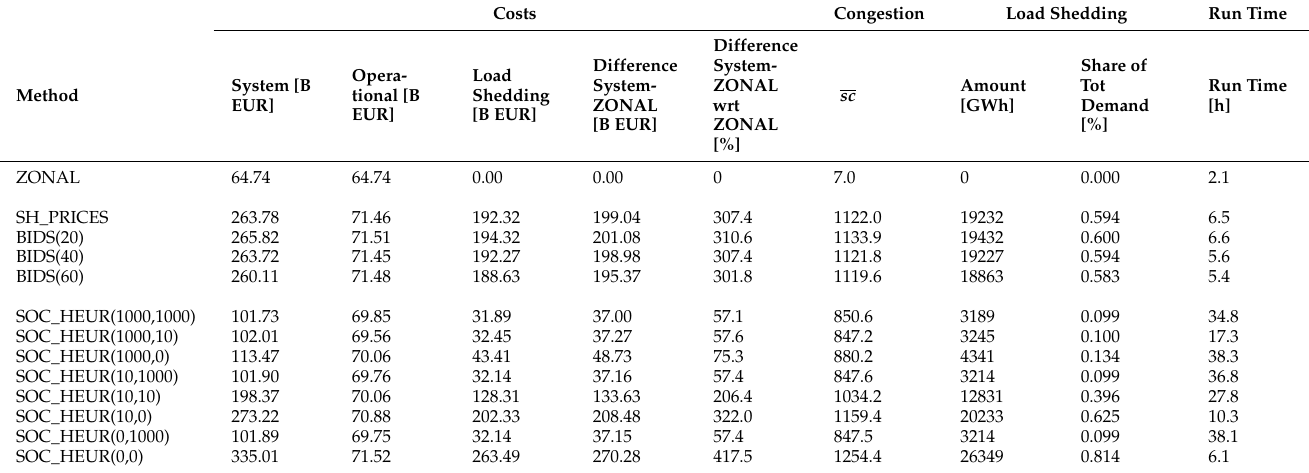
Table 4. Results overview for the long-time horizon benchmark with transmission capacity factor β = 0.5. Reported are for the different methods: the total system costs, which are made up of operational costs (i.e., power generation costs) and load shedding costs, the difference between ZONAL and the respective method in absolute amount and relative to the total system costs of ZONAL ; the average system congestion ( sc ); the total amount of load shed and the share of this amount with respect to the total load; and the run